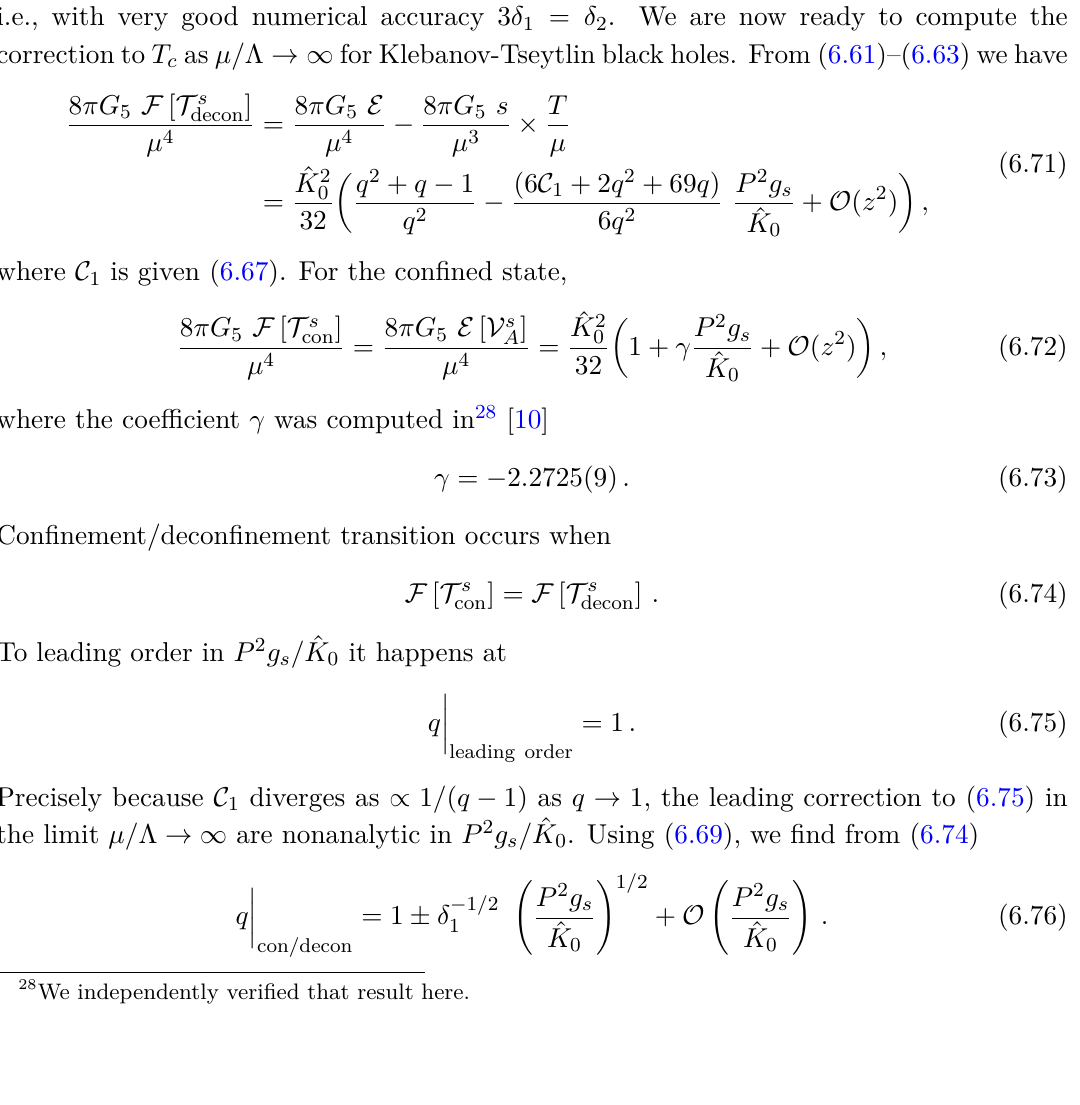
1. The dashed black lines are the tangents to the curves →